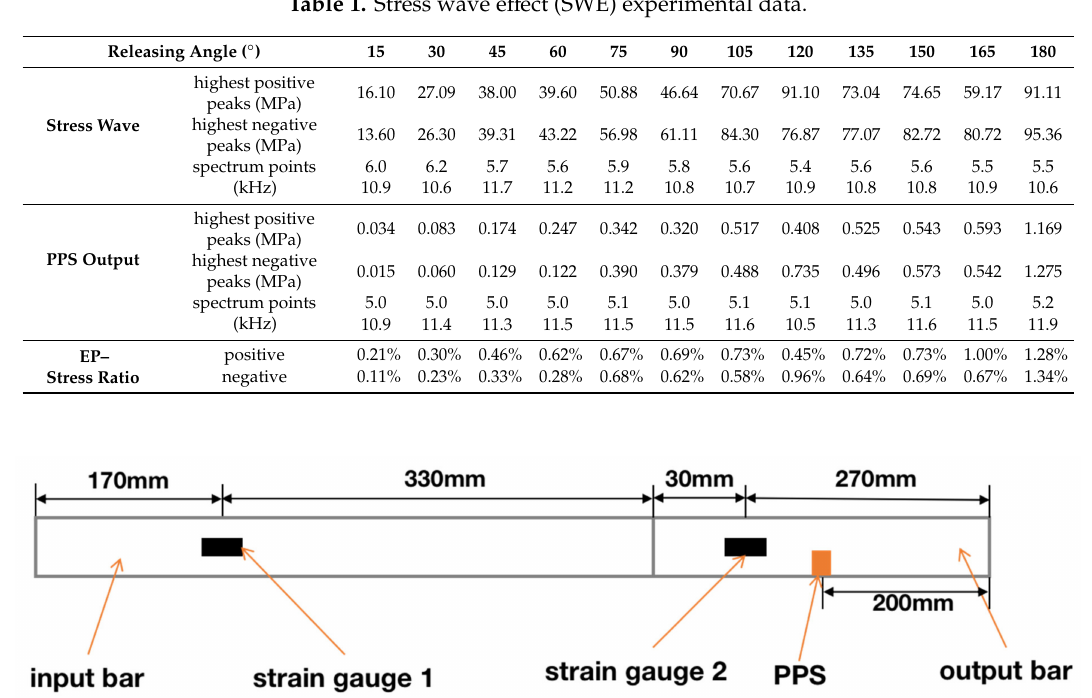
Figure 4. Geometric position relationship between the strain gauges and bars. The line between the two bars is the standard line of the geometric distance.